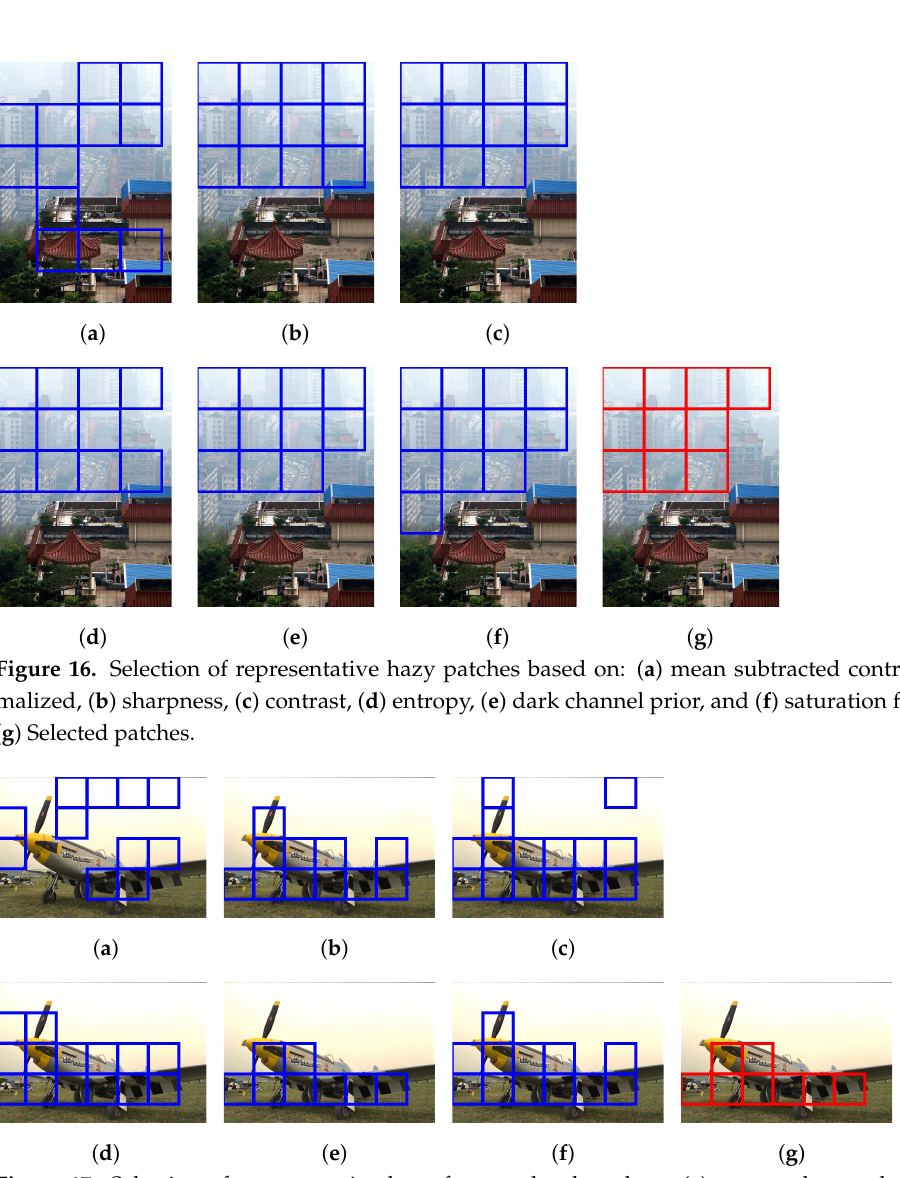
Figure 17. Selection of representative haze-free patches based on: ( a ) mean subtracted contrast normalized, ( b ) sharpness, ( c ) contrast, ( d ) entropy, ( e ) dark channel prior, and ( f ) saturation features. ( g ) Selected